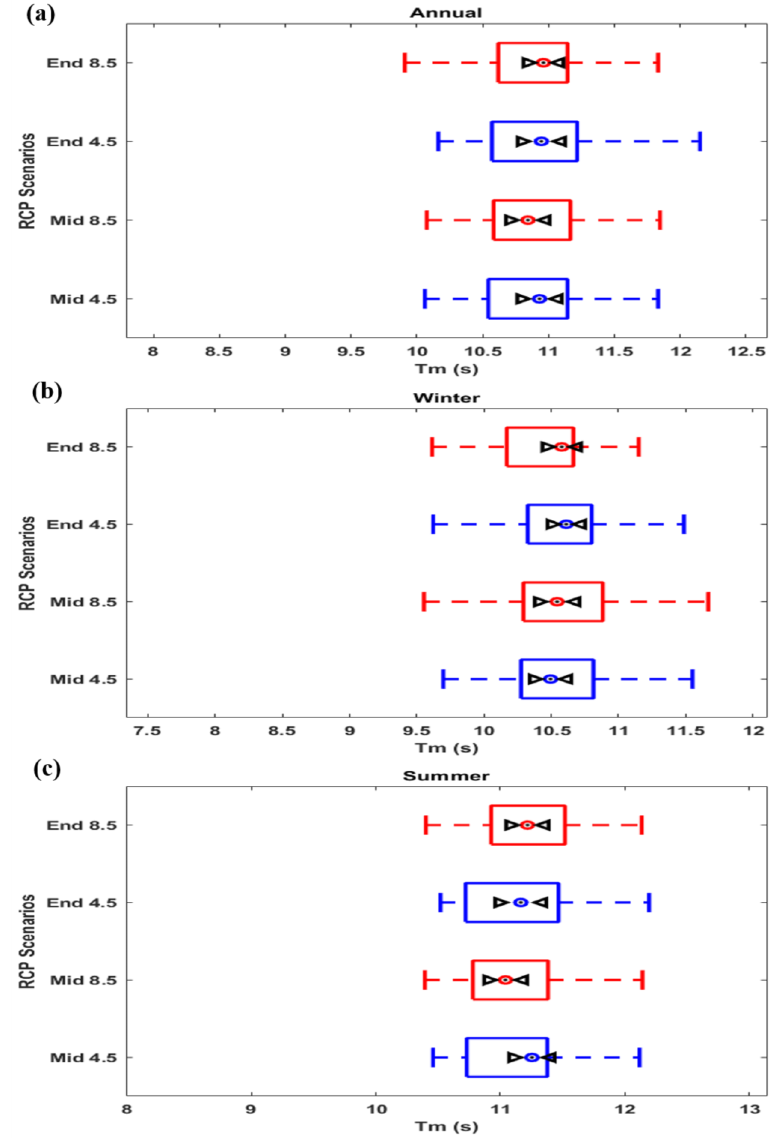
Figure 11. Boxplots showing the overlaps between Tm means for all future RCP scenarios with blue and red boxplots representing the RCP 4.5 and RCP 8.5, respectively for ( a ) annual ( b ) winter ( c ) summer.